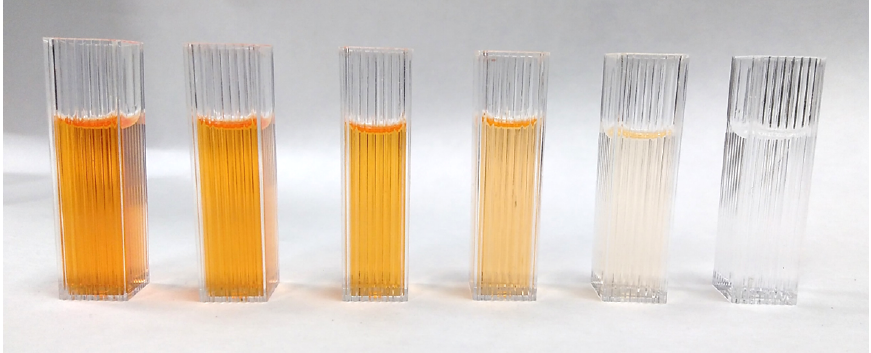
Figure 2. Ethanolic solutions of methyl red azoic dye from lower ( left ) to higher ( right )